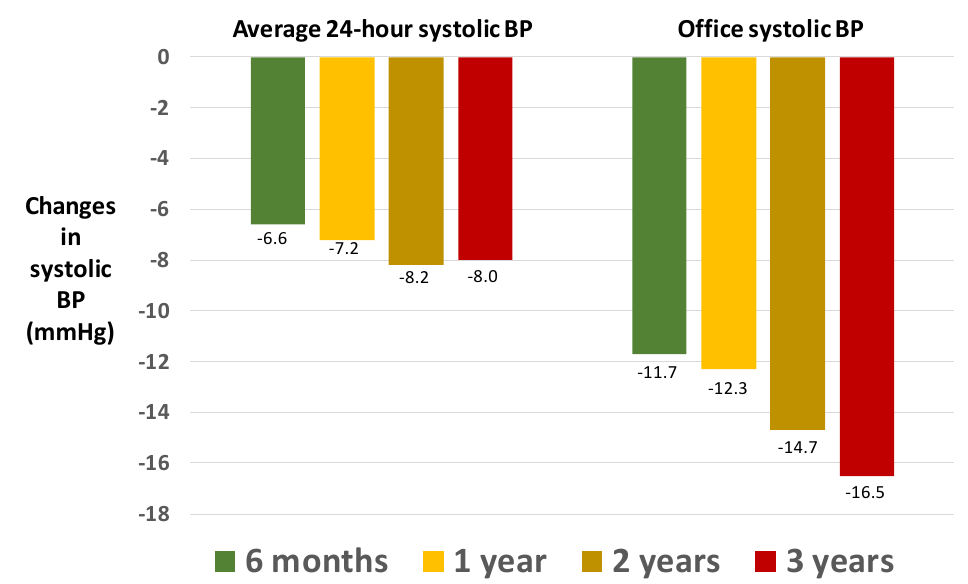
Figure 5. Long-term reduction in systolic BP in the open, non-comparative Global SIMPLICITY Registry. Adapted from Mahfoud and coworkers [89,92].